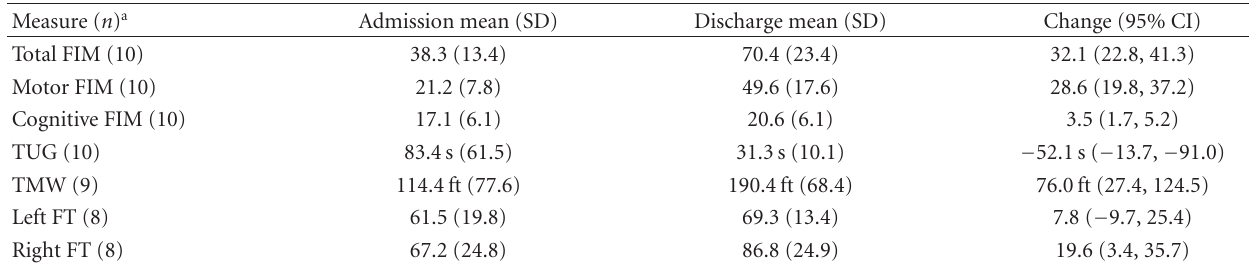
Table 4: Patients receiving rehabilitation